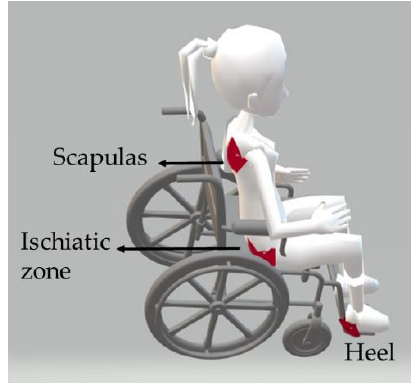
Figure 1. Representation of the most prominent bone zones for a wheelchair user.